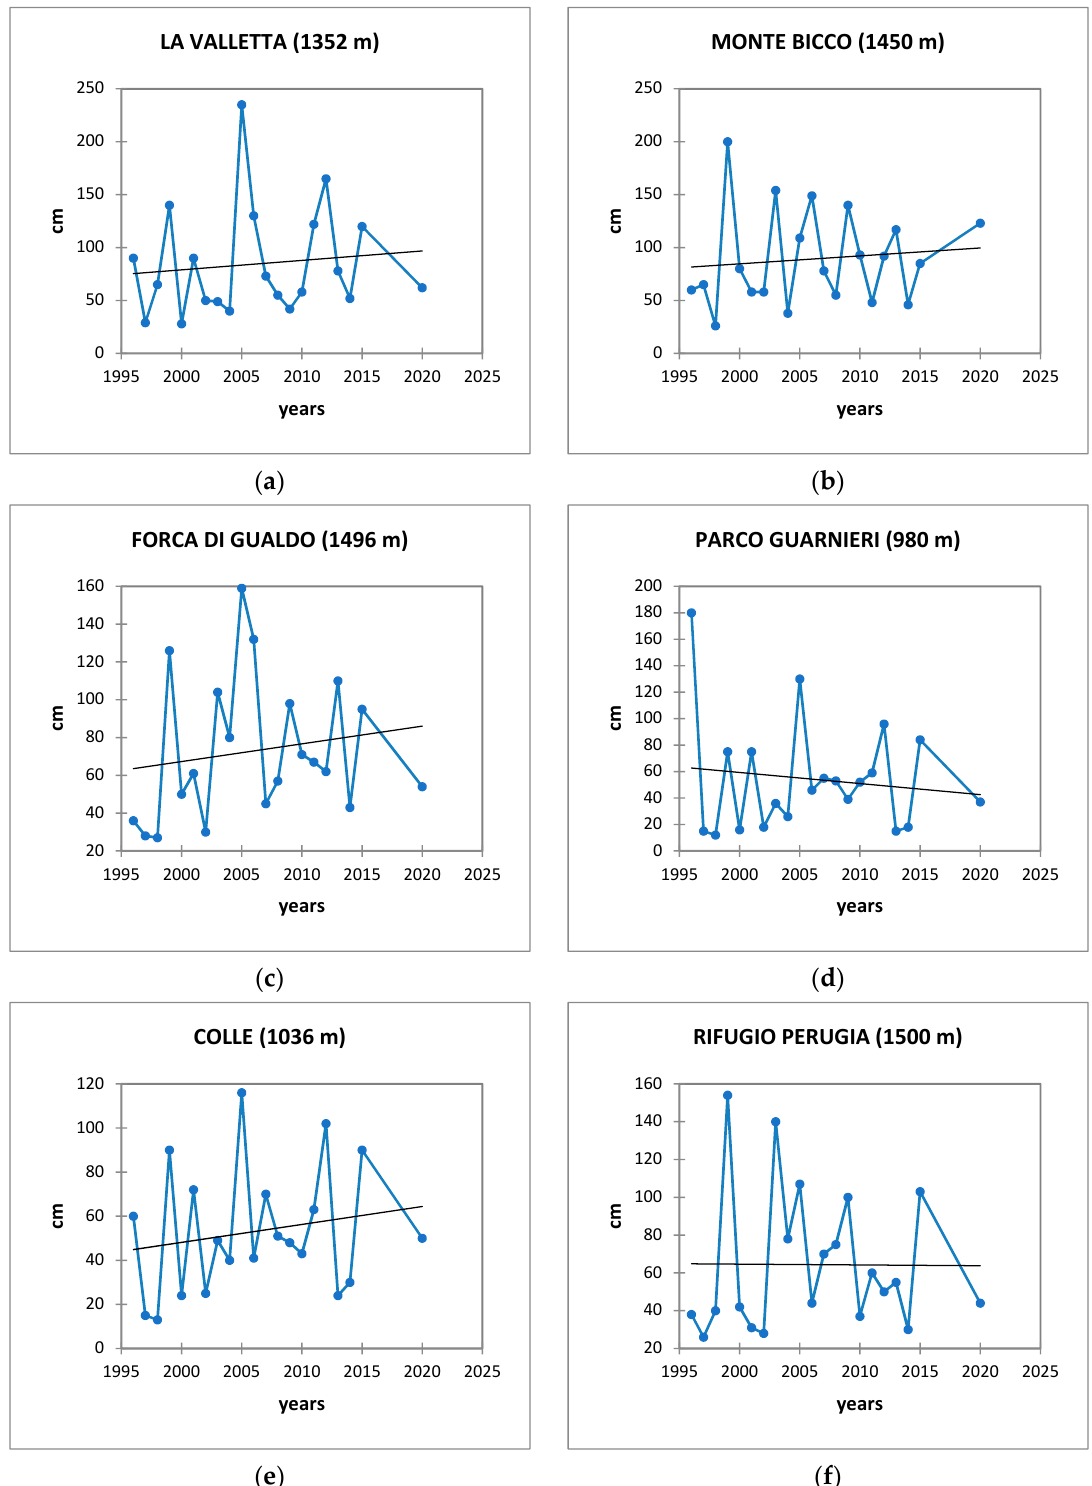
Figure 4. Trend of maximum annual snow depths from 1991 to 2020; the trend line is in black, for the weather stations: ( a ) La Valletta, ( b ) Monte Bicco, ( c ) Forca di Gualdo, ( d ) Parco Guarnieri, ( e ) Colle, ( f ) Rifugio